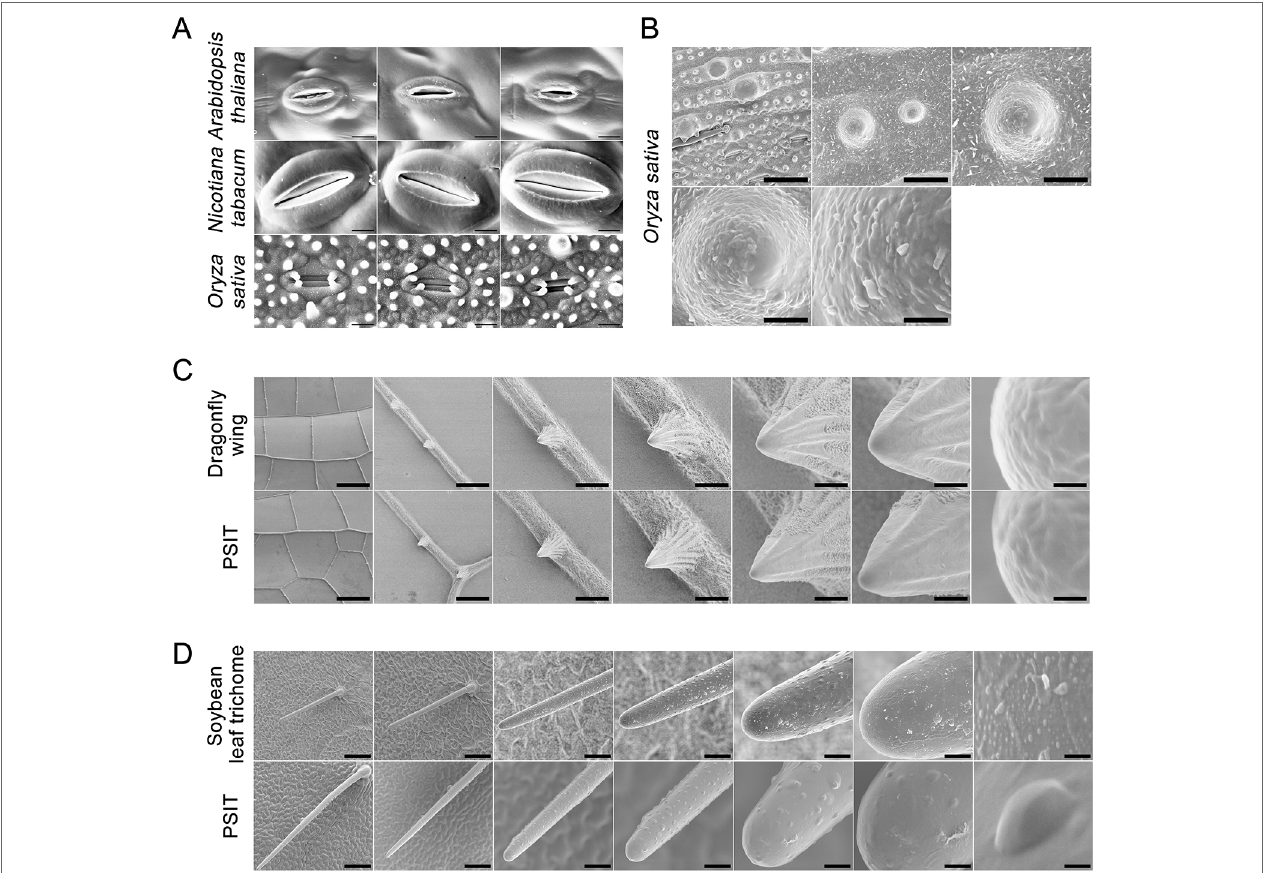
FIGURE 4 | Application of plant surface impression technique of the (PSIT) in Arabidopsis, tobacco, rice, soybean, and dragonfly. (A) The stomatal aperture of Arabidopsis, tobacco, and rice were determined by the PSIT. All sections were observed under SEM at 2,000× magnification. Scale bar = 20 μm. (B) Protrusions of the rice leaf were determined by the PSIT. The sections were observed under SEM at 1,000×, 5,000×, 10,000×, 20,000×, and 50,000× magnification, with 25, 5, 2.5, 1.25, and 0.5 μm scale bars indicated, respectively. (C) The structure of the dragonfly wing. The surface structure of the dragonfly wing was observed under SEM using dragonfly wing tissue and PSIT. From left to right, the magnification was 50×, 400×, 1,000×, 2,000×, 5,000×, 10,000×, and 100,000×, respectively. The corresponding scale bars were 445, 56, 22, 11, 4.4, 2.2, and 0.22 μm, respectively. (D) Comparison of soybean leaf hair. The surface structure of leaf hair was observed under SEM using soybean leaf tissue and the PSIT. From left to right, the magnification was 220×, 300×, 1,000×, 2,000×, 5,000×, 10,000×, and 100,000×, respectively. The corresponding scale bars are 100, 73, 22, 11, 4.4, 2.2, and 0.22 μm respectively.